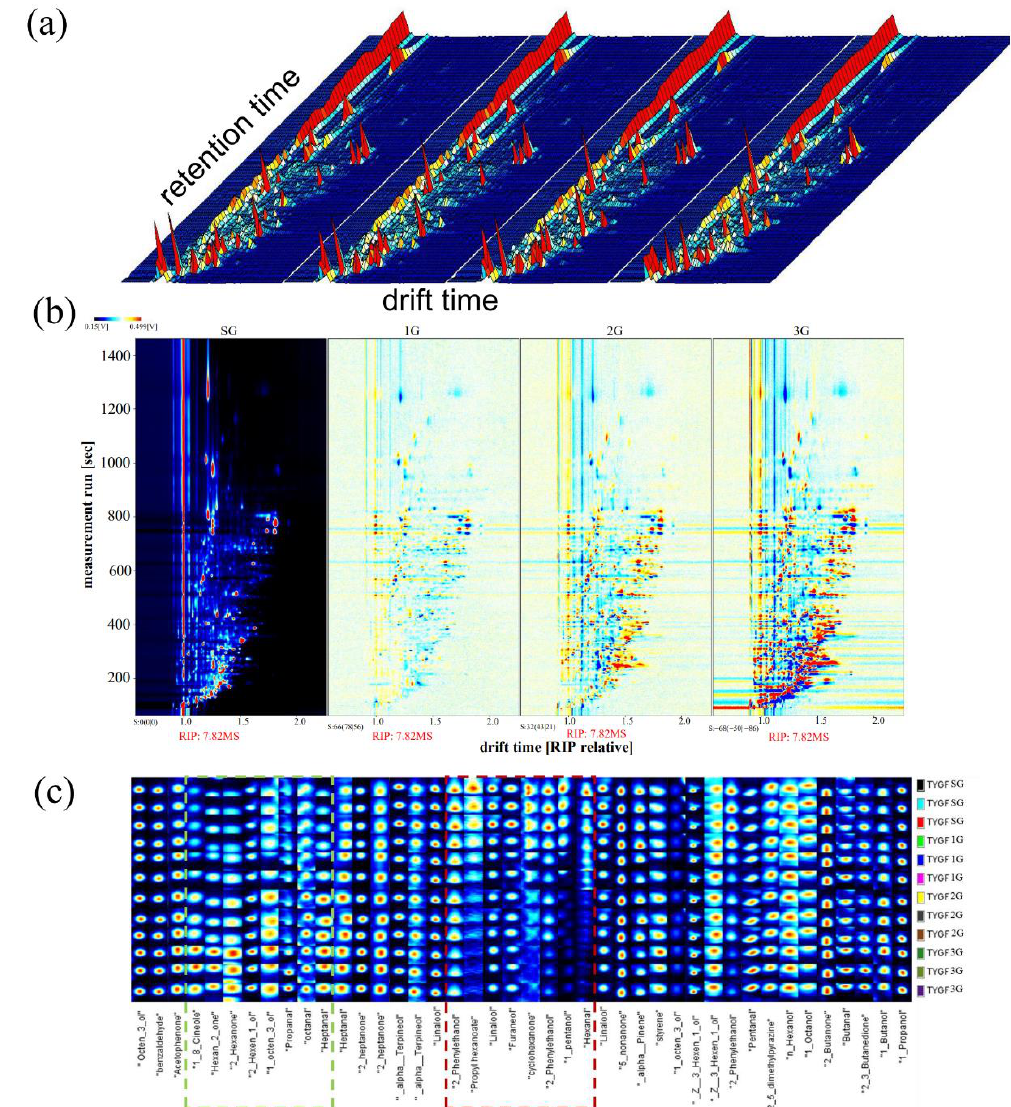
Figure 4. A comparison of the HS-GC-IMS spectra of the VOCs. ( a ) The 3D topographical plots for VOCs with peak spectra. The vertical coordinate represents the retention time of gas chromatography, whereas the horizontal coordinate represents the ion migration time. The background of the whole figure is blue, and the red vertical line at abscissa 1.0 is the RIP peak (reactive ion peak, after normalization). ( b ) The two-dimensional graph with the super-grade as a reference. ( c ) Gallery plot of the selected signal peak areas obtained for different grades of the PCT standard samples. As the grade decreases, the red outline indicates VOCs with decreased intensities, and the green outline indicates VOCs with increased intensities.